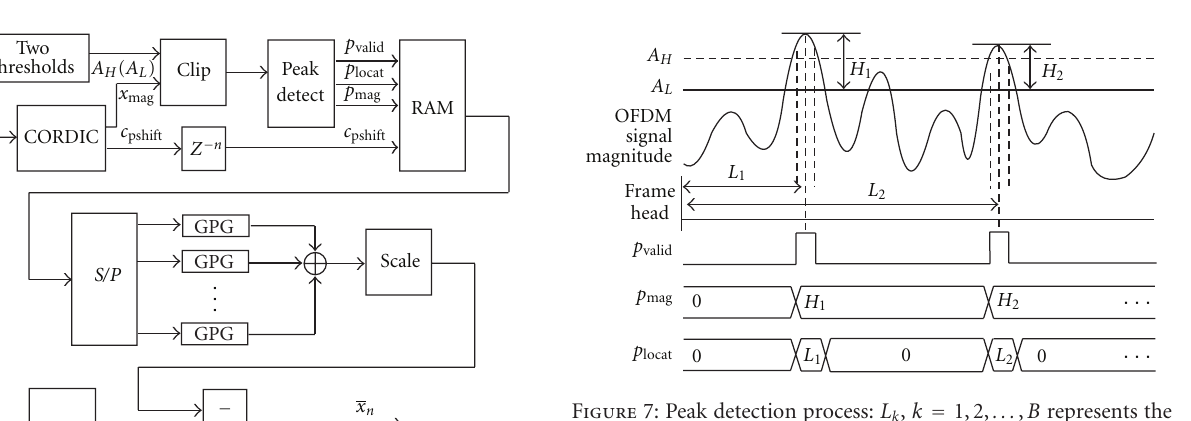
Figure 7: Peak detection process: L k , k = 1,2, ... , B represents the location information of the i th peak, while H k , k = 1,2, ... , B gives the delta magnitude of the peak referring to the